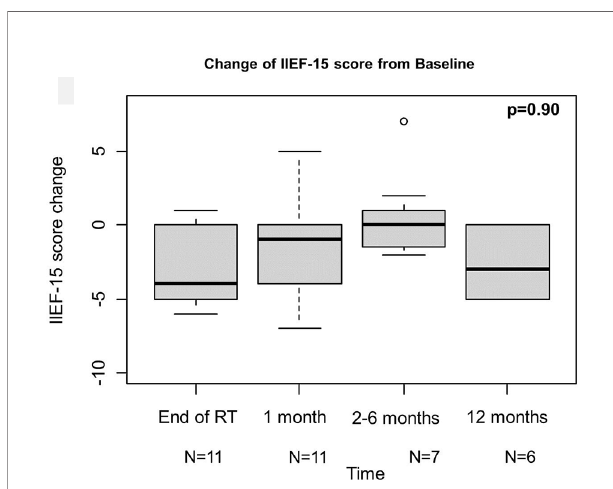
FIGURE 3 | Results of IIEF-15. IIEF-15, international index of erectile